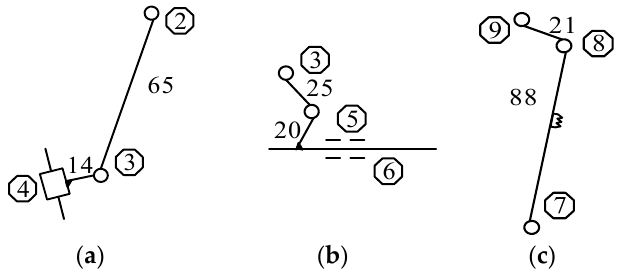
Figure 5. Source metamorphic elements of the feed mechanism. ( a ) Metamorphic element 1. ( b ) Metamorphic element 2. ( c ) Metamorphic element 3.